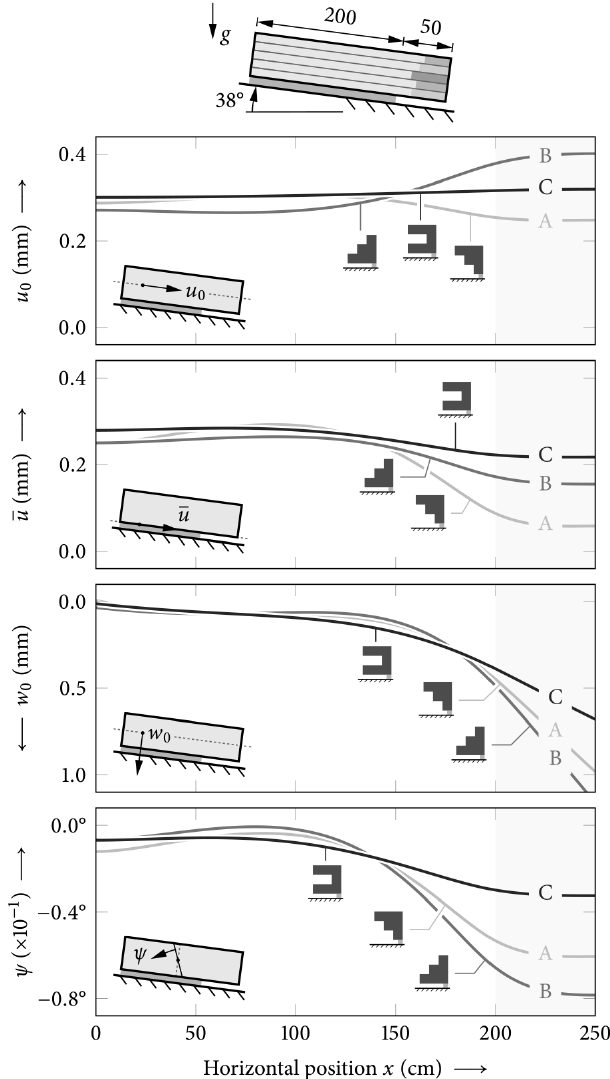
Figure 12. Deformations along the length of a PST with a cut at x = 200cm (cut length 50cm) illustrated by the shaded back- ground. Comparison of three snow profiles. The longitudinal dis- placement of the midplane of the slab u 0 and at the interface be- tween slab and weak layer ¯ u , the deflection w 0 , and the cross- section rotation ψ are